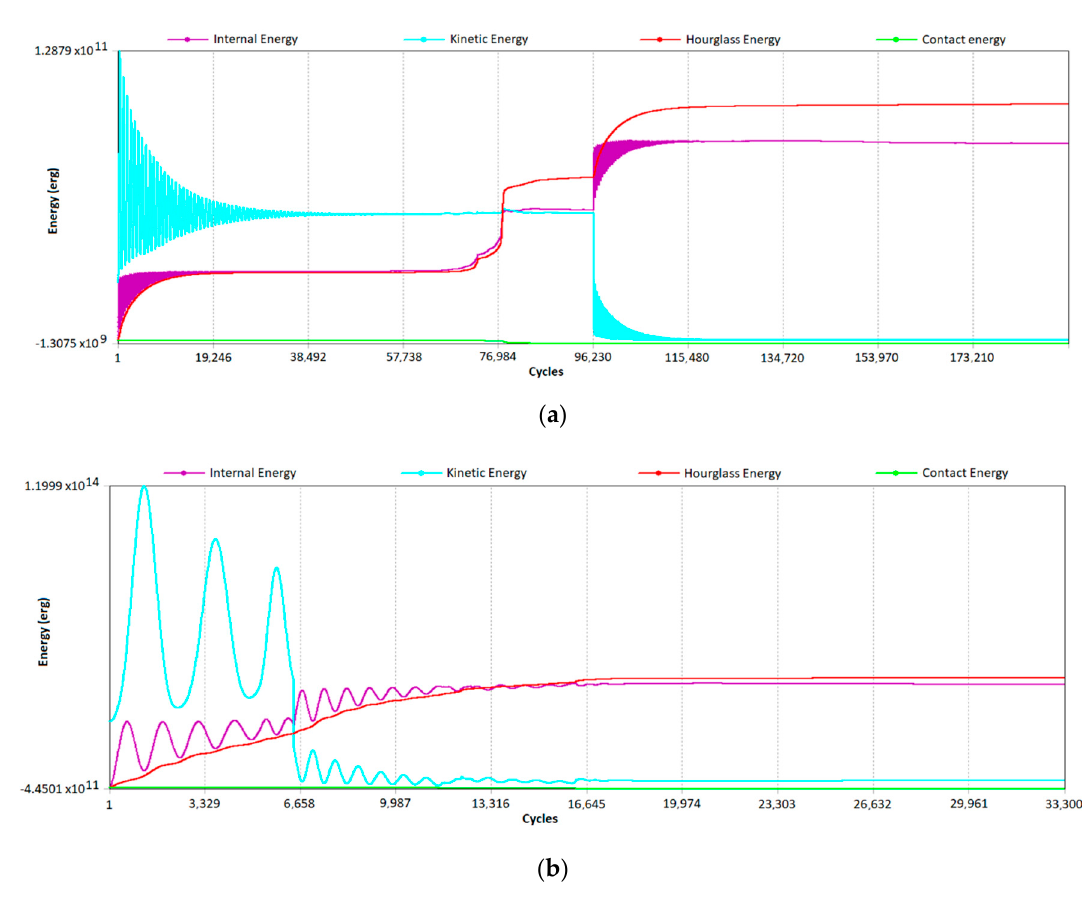
Figure 13. Diagrams of the tulip contact motion analysis: ( a ) Energy summary—normal operation and ( b ) energy summary—contact destruction.